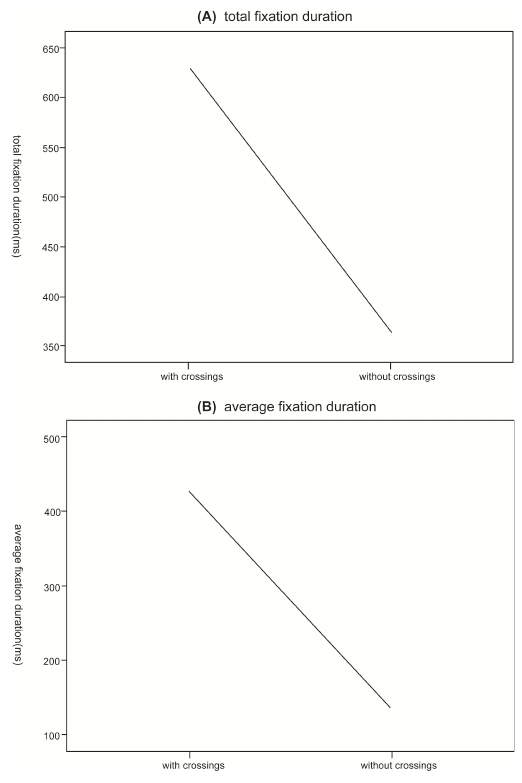
Figure 7. Total fixation duration and average fixation duration of characters with and without crossings